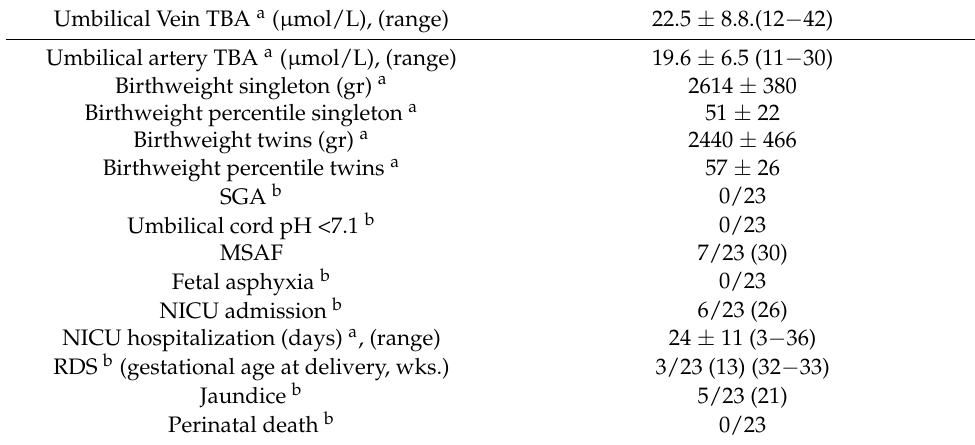
Table 2. The neonatal outcome. Umbilical Vein TBA a ( µ mol/L), (range)